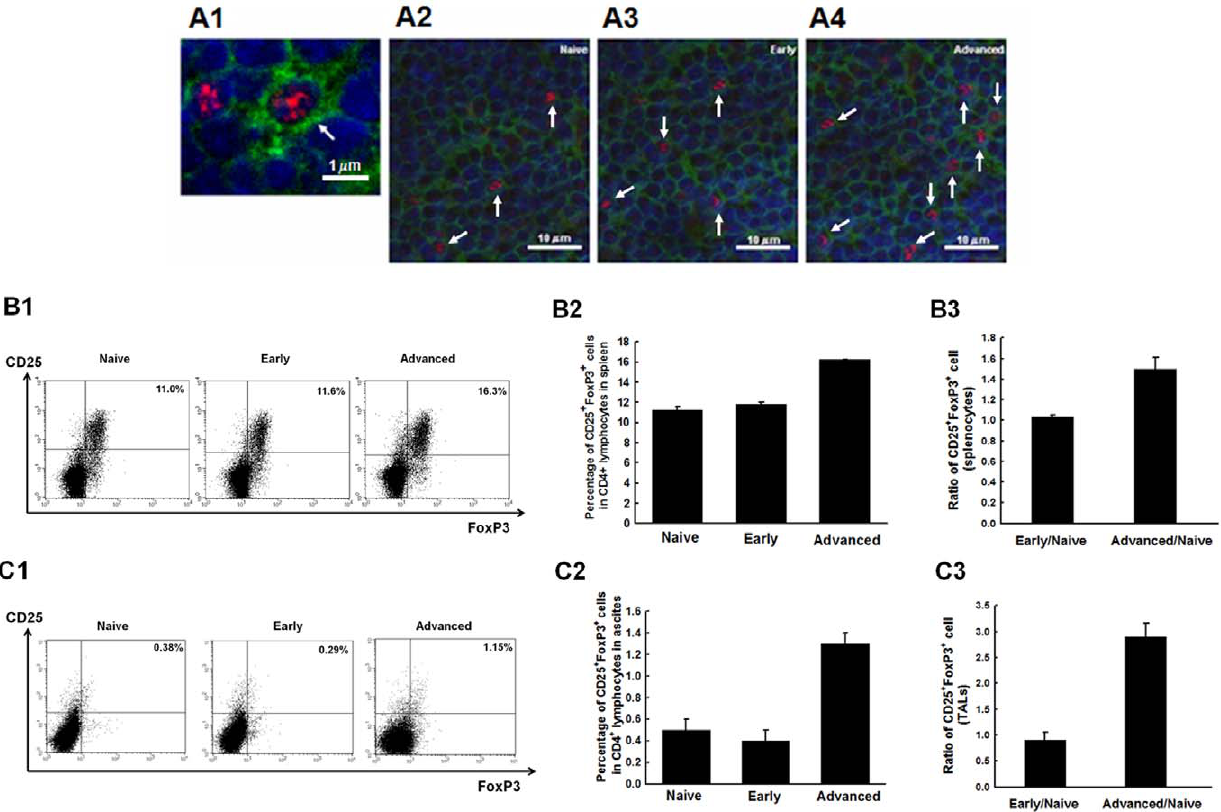
Figure 4. Kinetic changes of Treg cells in the splenocytes and TACs of mice challenged with PBS or WF-3 tumor cells. ( A ) Representative figures of CD4 + FoxP3 + Treg cells in the spleen of mice by immuno-histochemistry staining observed under confocal microscopy. A1, A single CD4 + FoxP3 + regulatory T cell (blue: nucleus, green: CD4, red: FoxP3); A2, PBS group; A3, WF-3 group with early disease; A4, WF-3 group with advanced disease (arrows: CD4 + FoxP3 + Treg cells). ( B ) CD4 + CD25 + FoxP3 + Treg cells in splenocytes. B1: Representative figures of flow cytometric analyses. B2: The bar figures of CD4 + CD25 + FoxP3 + Treg cells in various groups. B3: The ratios of CD4 + CD25 + FoxP3 + Treg cells. Note: Referenced with the naı¨ve group, Treg cells of the advanced stage group were 1.5-fold higher in splenocytes. ( C ) CD4 + CD25 + FoxP3 + Treg cells in TACs. C1: Representative figures of flow cytometric analysese. C2: The bar figures of CD4 + CD25 + FoxP3 + Treg cells in various groups. C3: The bar figures of the ratios of CD4 + CD25 + FoxP3 + Treg cells in various groups. Note: Referenced with the naı¨ve group, Treg cells were 2.9-fold higher in TACs of the advanced stage group.